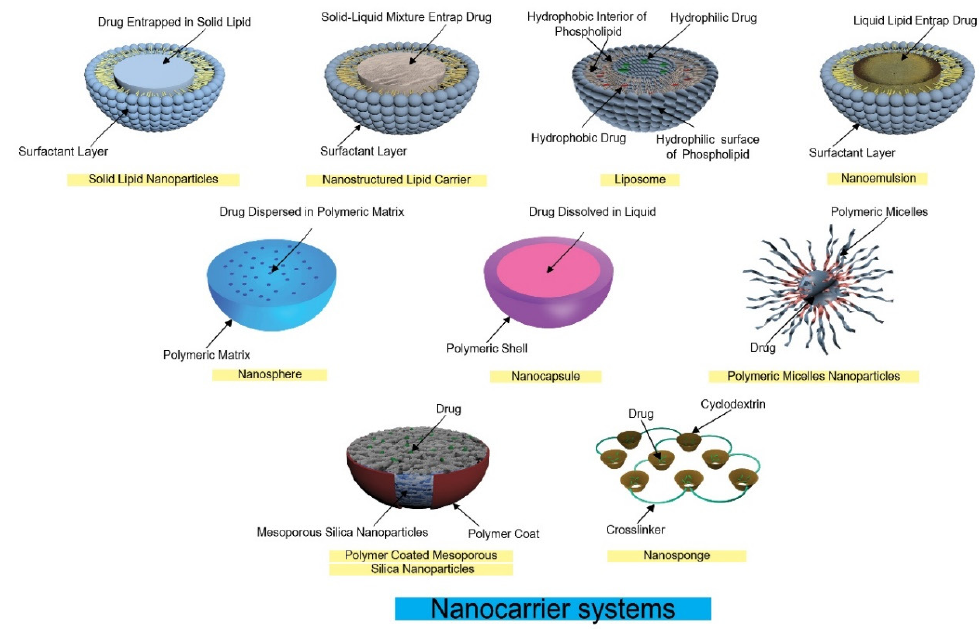
Figure 3. Different nanocarrier systems used for taste masking. Table 2. Nanocarrier systems formulated to mask the taste of different drugs.